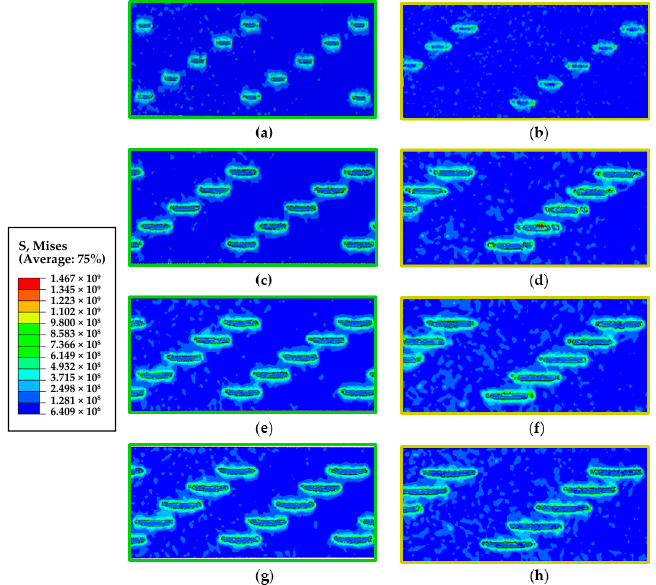
Figure 6. Simulation result comparisons of groups 2 and 3: ( a ) 𝑛 = 2000 RPM , 𝑉 (cid:3046) = 1 μm/s , ( b ) 𝑛 = 3000 RPM , 𝑉 (cid:3046) = 1 μm/s , ( c ) 𝑛 = 2000 RPM , 𝑉 (cid:3046) = 10 μm/s , ( d ) 𝑛 = 3000 RPM , 𝑉 (cid:3046) = 10 μm/s , ( e ) 𝑛 = 2000 RPM , 𝑉 (cid:3046) = 20 μm/s , ( f ) 𝑛 = 3000 RPM , 𝑉 (cid:3046) = 20 μm/s , ( g ) 𝑛 = 2000 RPM , 𝑉 (cid:3046) = 30 μm/s and ( h ) 𝑛 = 3000 RPM , 𝑉 (cid:3046) = 30 μm/s .